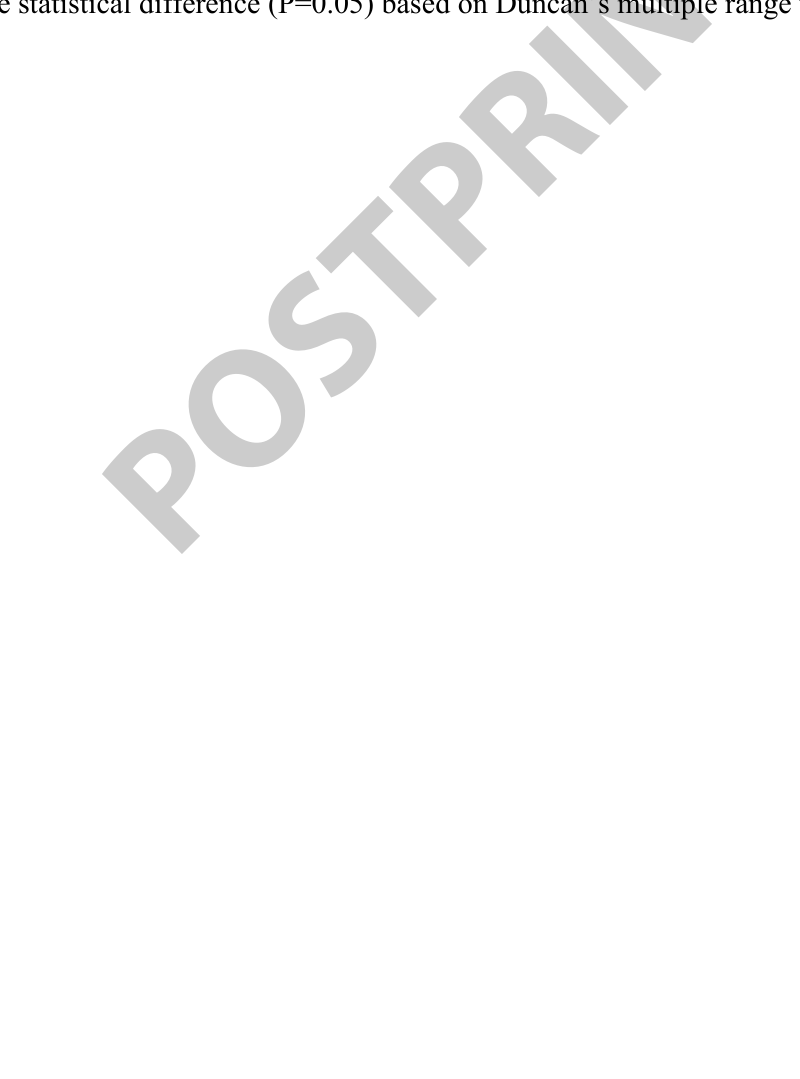
Figure 8 IC 50 value of the different solvent extracts of Astraeus asiaticus (± SD is depicted at the top of data bar). Similar letters at the top of data bars indicate statistical similarity, while different letters indicate statistical difference (P=0.05) based on Duncan’s multiple range